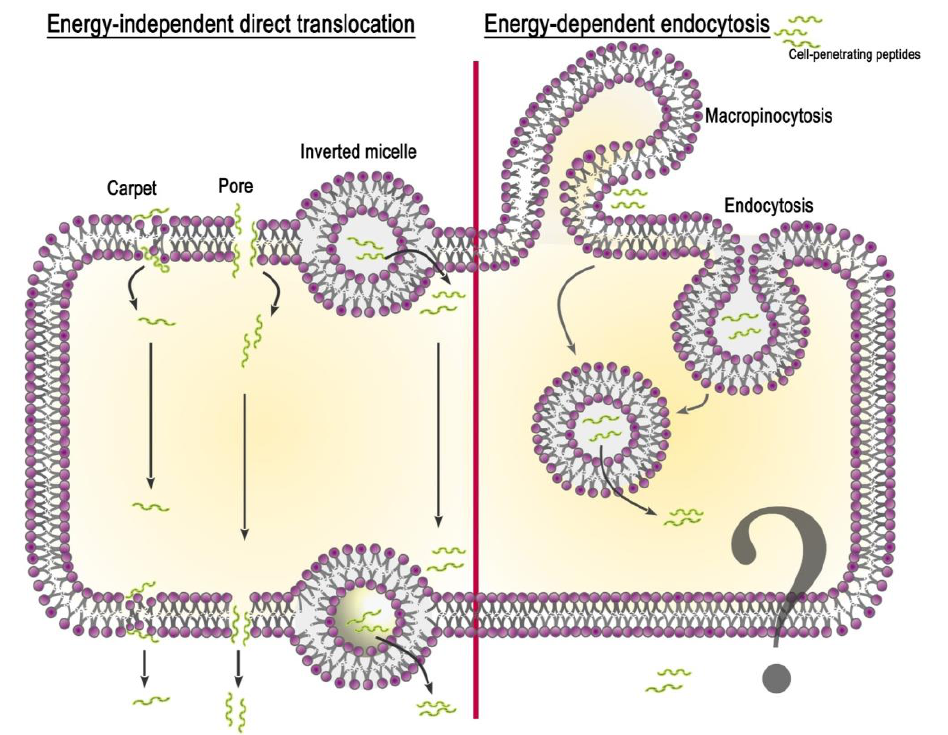
Figure 1. Schematic representation of proposed mechanisms for CPP internalization.